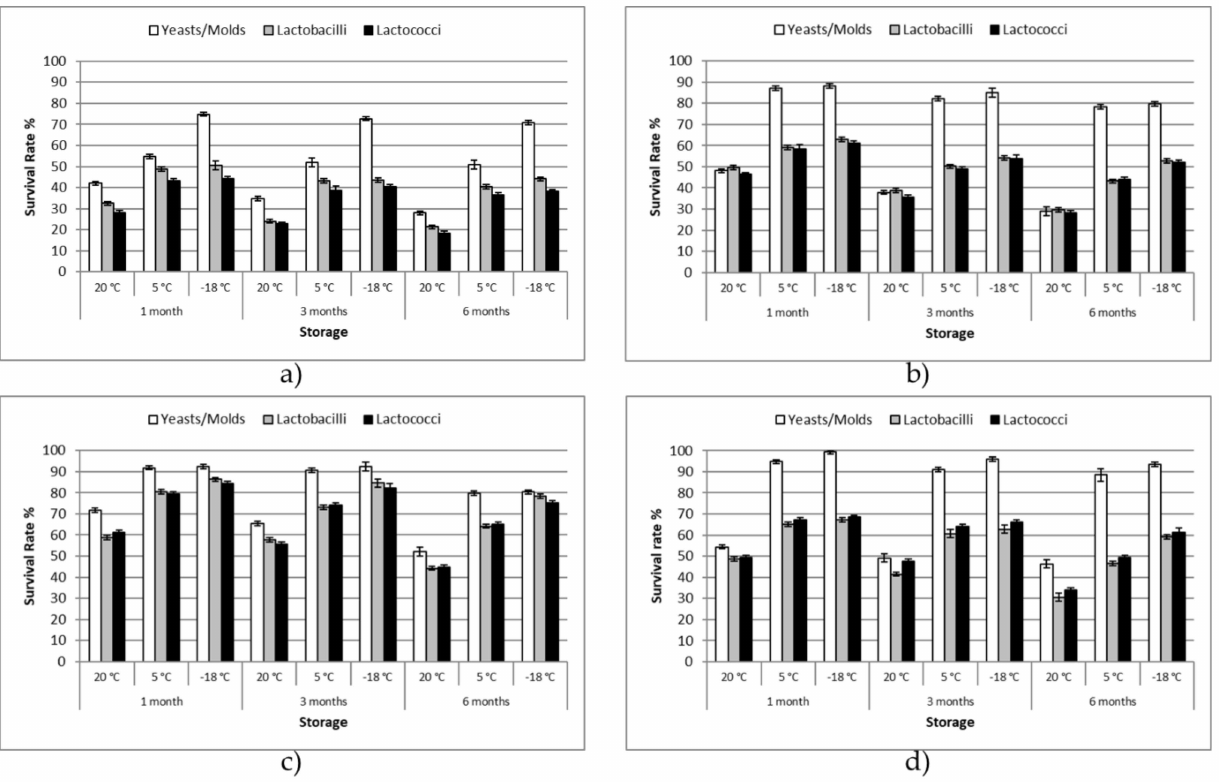
Figure 1. Survival rate (%) of thermally-dried free and immobilized kefir cells. ( a ) Free kefir culture, ( b ) immobilized kefir cells on apple pieces, ( c ) immobilized kefir cells on delignified cellulosic material (DCM), ( d ) immobilized kefir cells on grape